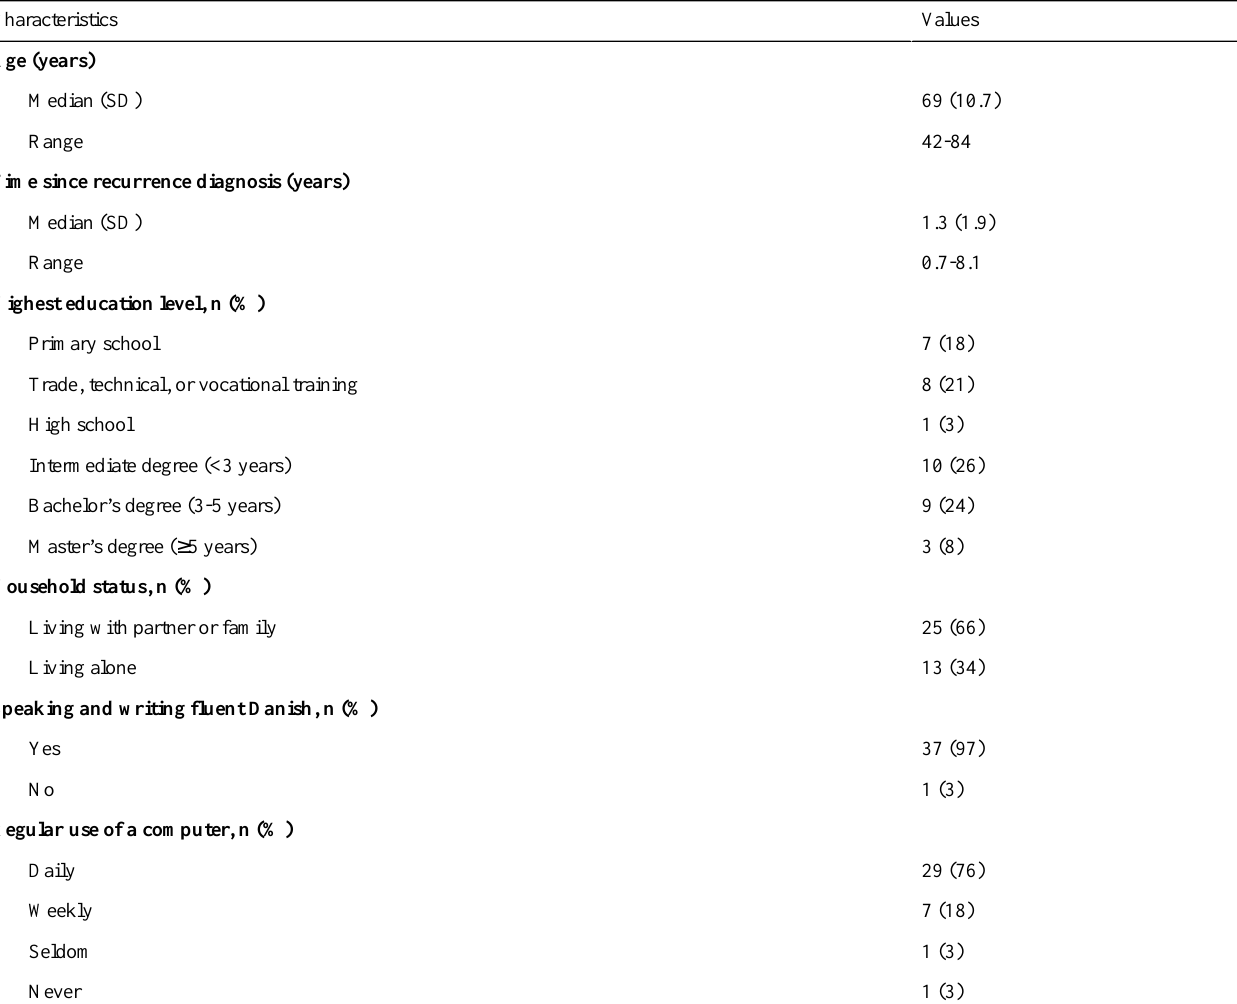
Table 1. Characteristics of 38 white women with metastatic breast cancer who completed the online questionnaire.